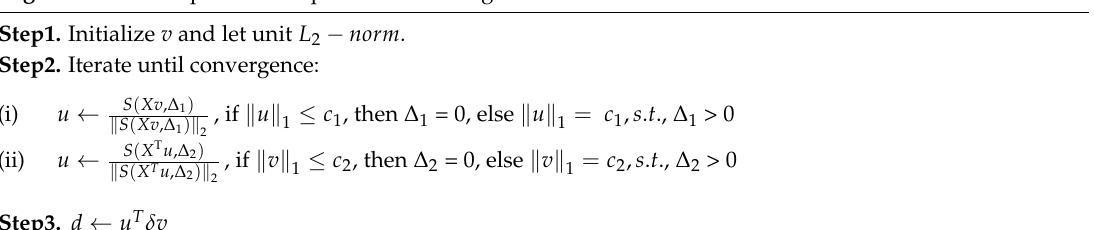
Algorithm 3. The optimization process of the single factor